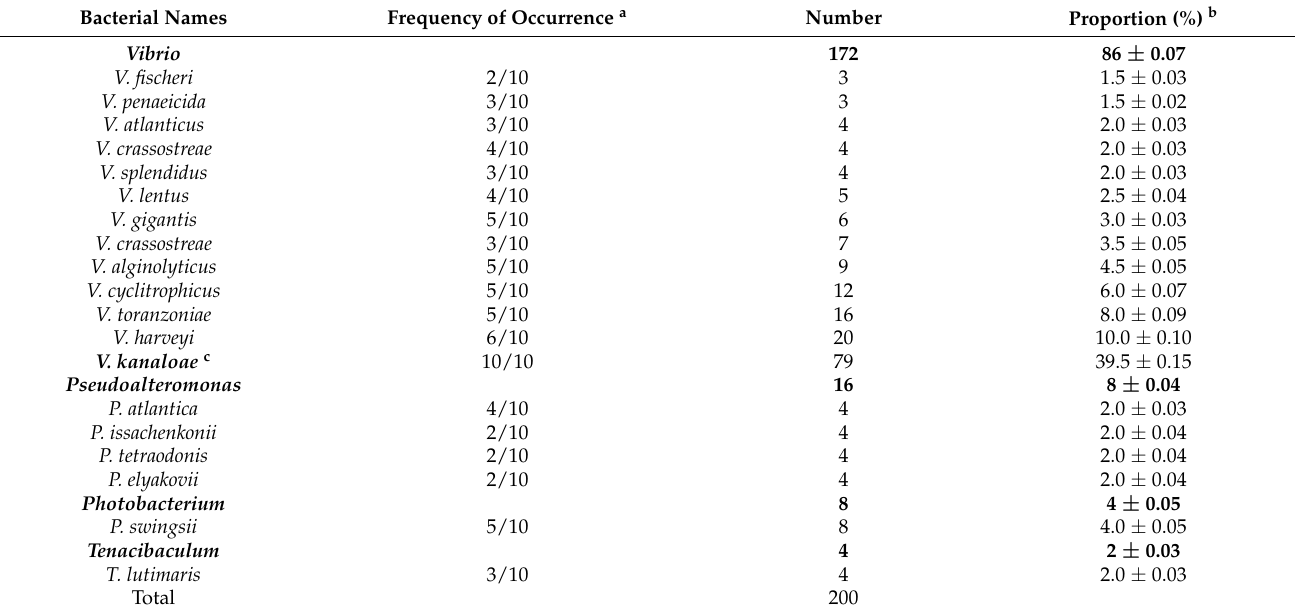
Table 2. Bacteria isolated from the diseased S. broughtonii. Bacterial